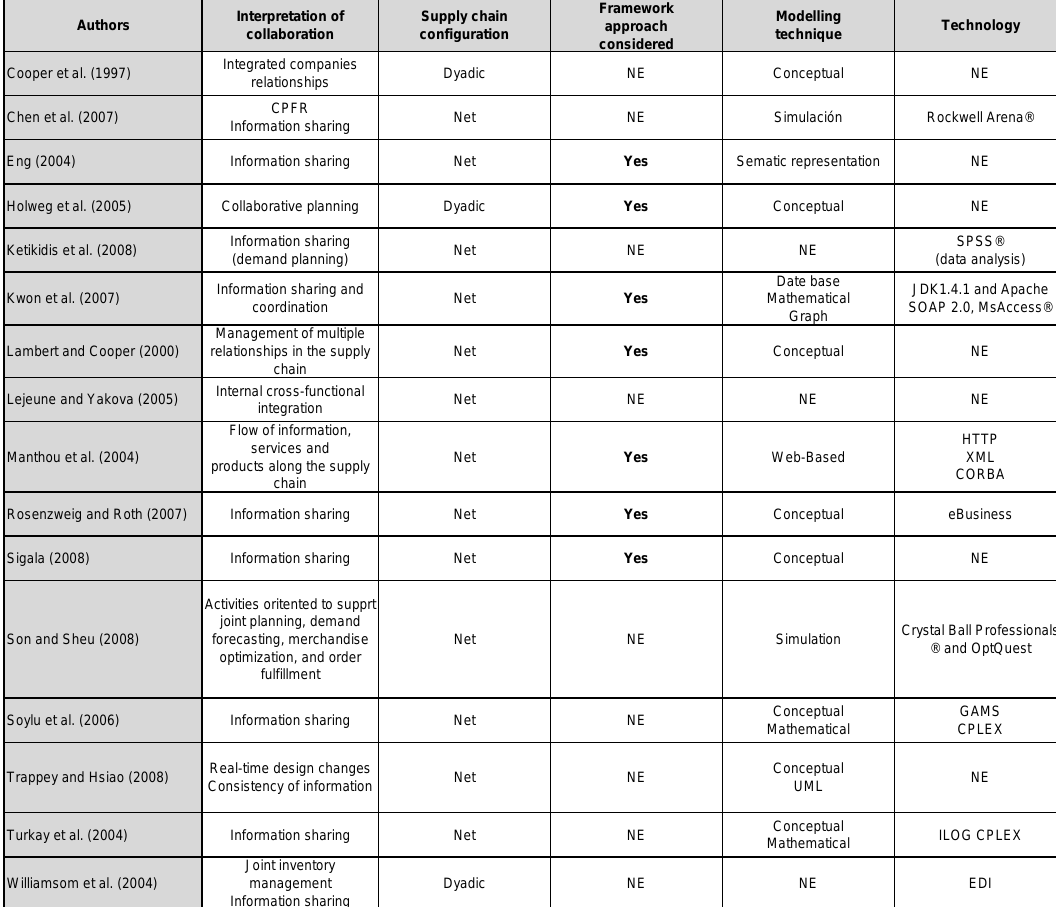
Table 1. “Relevant collaborative aspect within supply chain